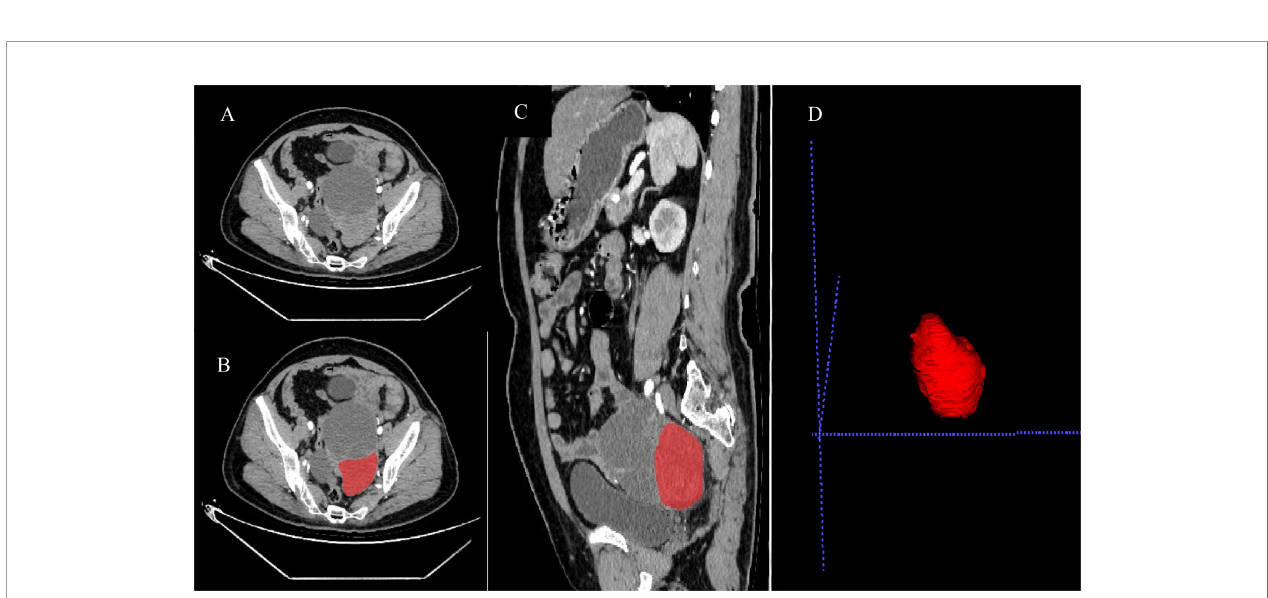
FIGURE 3 | Preoperative enhanced CT arterial phase images of patients with wild-type BRCA (A) , as well as processing images (B – D) after ROIs were drawn by ITK-SNAP software. matching between two sets of images and conduct pattern feature extraction. Finally, the software extracted 653 features and provided 6 major types of analysis: histograms, a gray unicom regional matrix, neighborhood grayscale difference matrix, gray level co-occurrence matrix, morphology, and a run-length matrix.